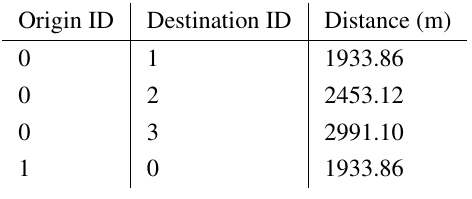
Table 1. Distance in OD